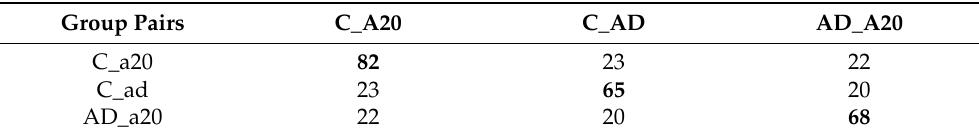
Table 3. Number of the AS2 DAS ES common events between three mouse groups (Table S4b). The overall DAS numbers in the corresponding pairwise comparison are